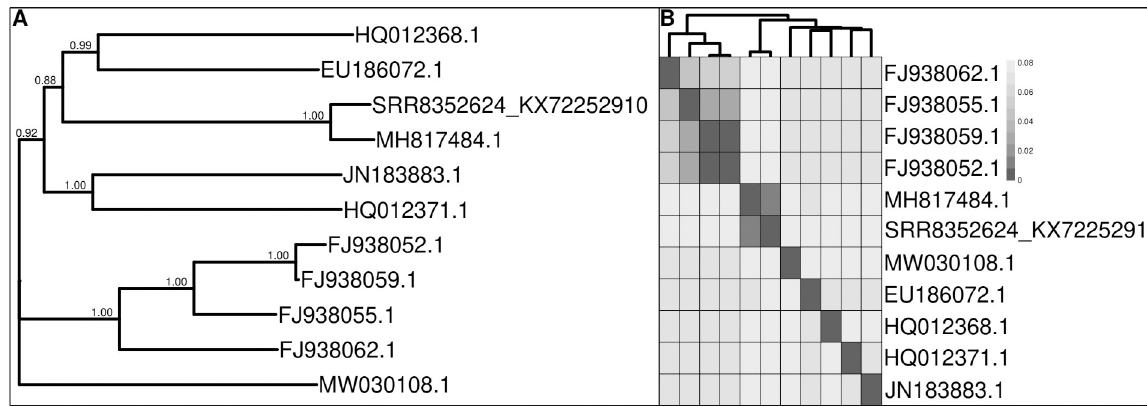
Fig 8. (A) Phylogenetic tree reconstructed for the best 10 BLAST hits using the consensus FCoV genome obtained using our pipeline and (B) pairwise sequence similarity shown on a heatmap of these sequences using raw distances (B). The sample name SRR8352624_KX72252910 represents the sequencing reads genotyped with our pipeline relying on alignments to the reference genome KX722529.1 and MH817484 shows the position of the publicly available reference genome of feline coronavirus strain FCoV-SB22[45].